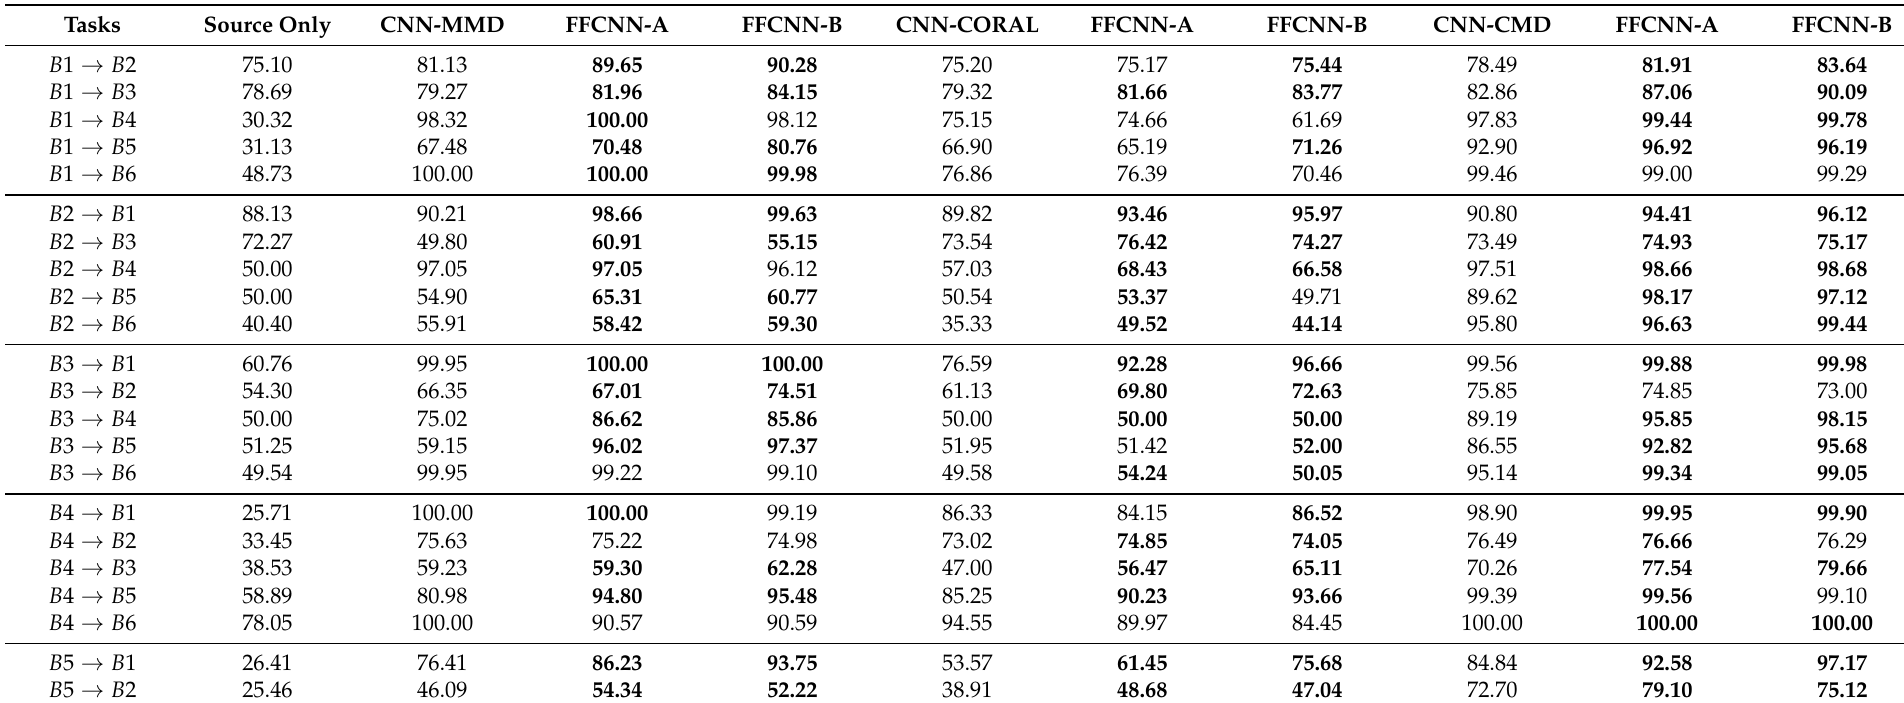
Table 4. Diagnosis accuracy (%) on different working conditions compared with different methods using CWRU dataset. The values in bold indicate that FFCNN has a higher accuracy rate than